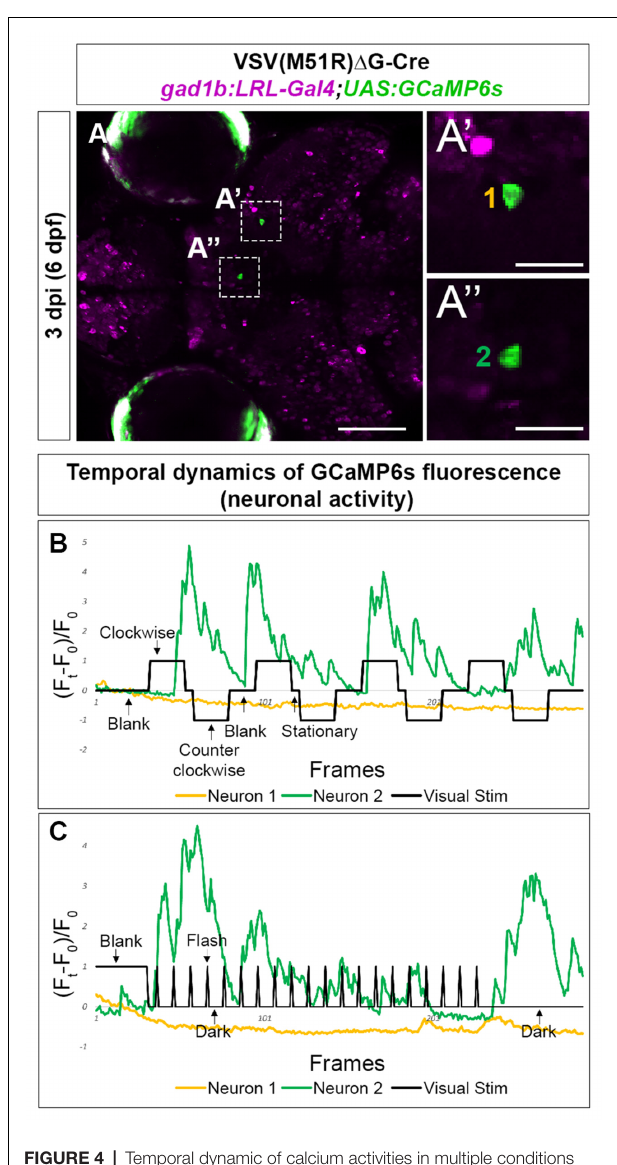
FIGURE 4 | Temporal dynamic of calcium activities in multiple conditions captured from the neurons infected with VSV(M51R) ∆ G-Cre in gad1b:LRL-Gal4;UAS:GCaMP6s fish. All images shown are confocal optical sections. (A–A”) Neurons ( A’ —Mesencephalon neuron and A” —Dorsal Thalamus neuron) expressing GCaMP6s detected in one XY plain of the brain in a 3 dpi (6 dpf) fish. (B) The evoked transient calcium activity traces (F t − F 0 /F 0 ) during the whole-field display of moving gratings. (C) The evoked transient calcium activity traces during whole field display of 18-s dark/2-s bright flashes. Scale bar in (A) is 100 µ m. Scale bars in (A’,A”) are 25 µ